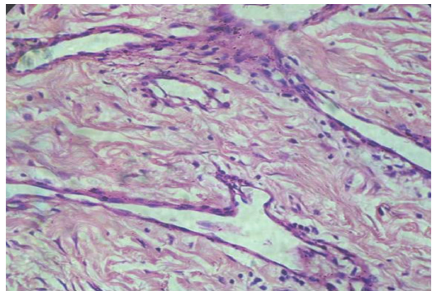
Figure 6: Large sinusoidal spaces surrounded by endothelial cells (hematoxylin and eosin stain